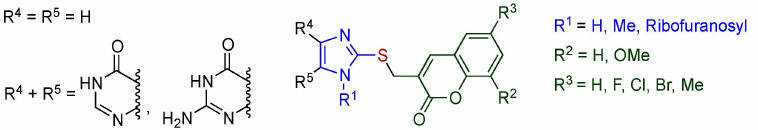
Figure 1. General structure of targed imidazole–coumarin